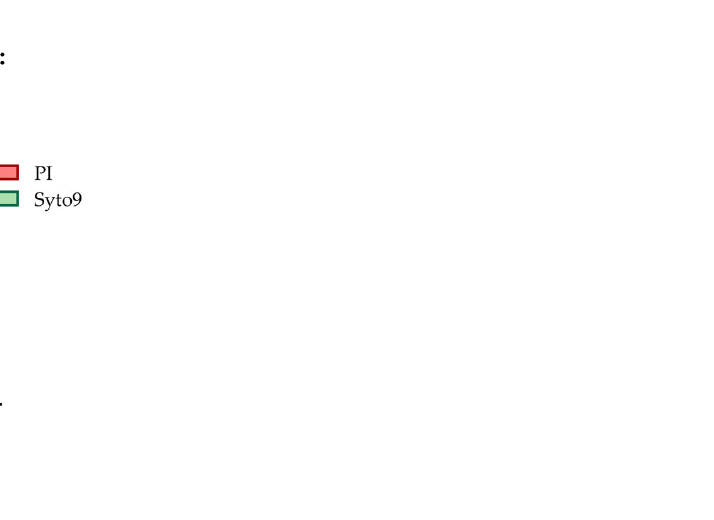
Figure 4. The fraction of propidium iodide (PI) and Syto9 stained cells in an E. coli culture sampled by fast filtration under controlled vacuum with and without a quick warm (37 ◦ C) water rinse on the filter, as estimated by fluorescence microscopy imagining. The average ± SD of n = 3 technical replicates is presented. > 3000 cells were counted per technical replicate. Significance levels from two ‐ tailed t ‐ tests assuming equal variances are marked ns: not significant.